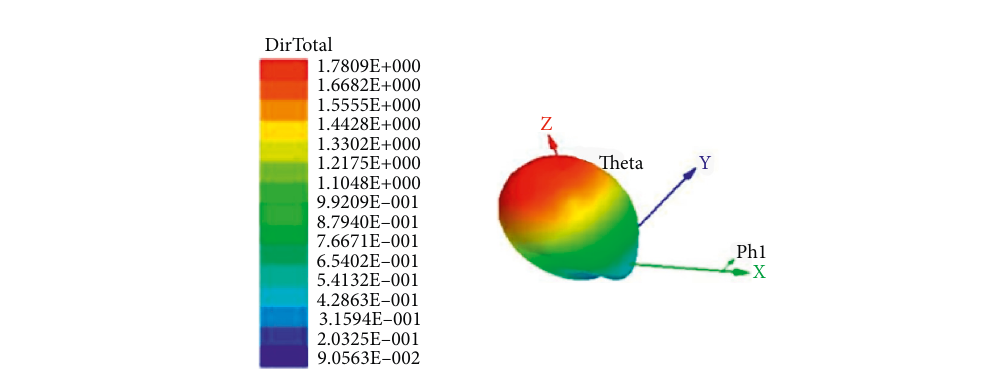
Figure 7: VSWR of designed circular patch antenna.